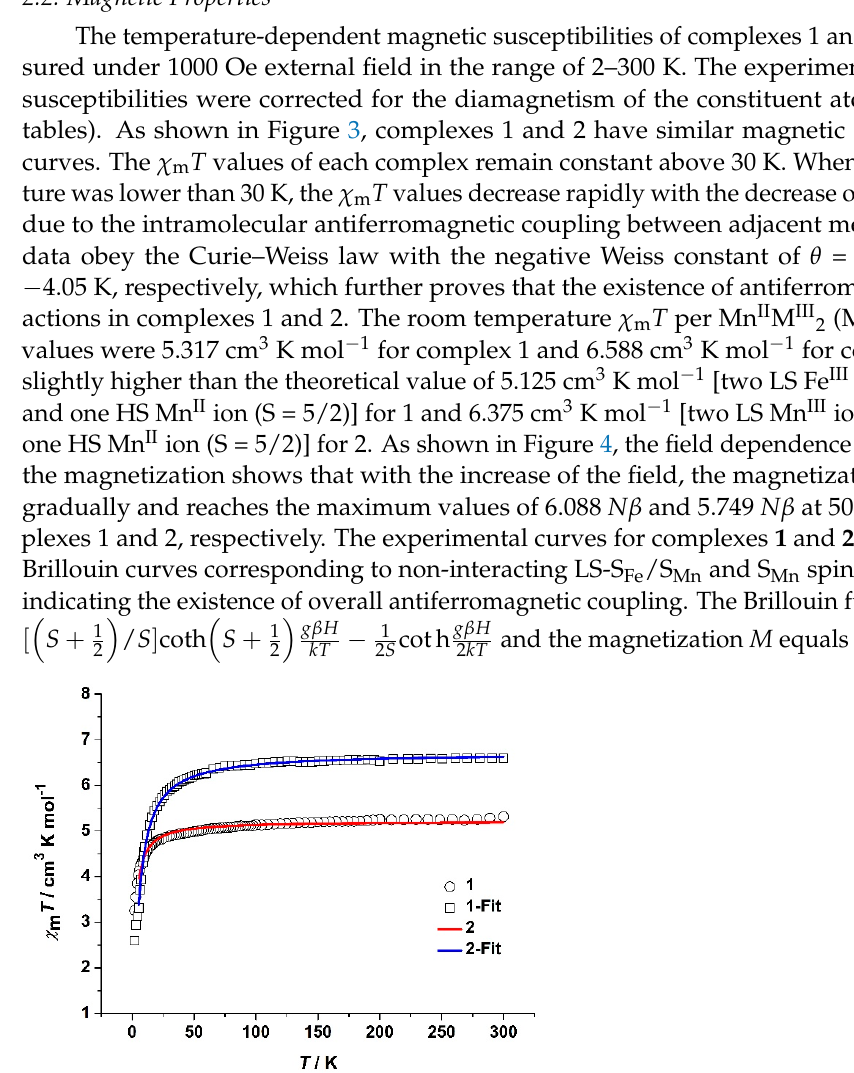
Figure 3. Variable-temperature magnetic susceptibilities for complexes 1 and 2 under a 1000 Oe applied field.